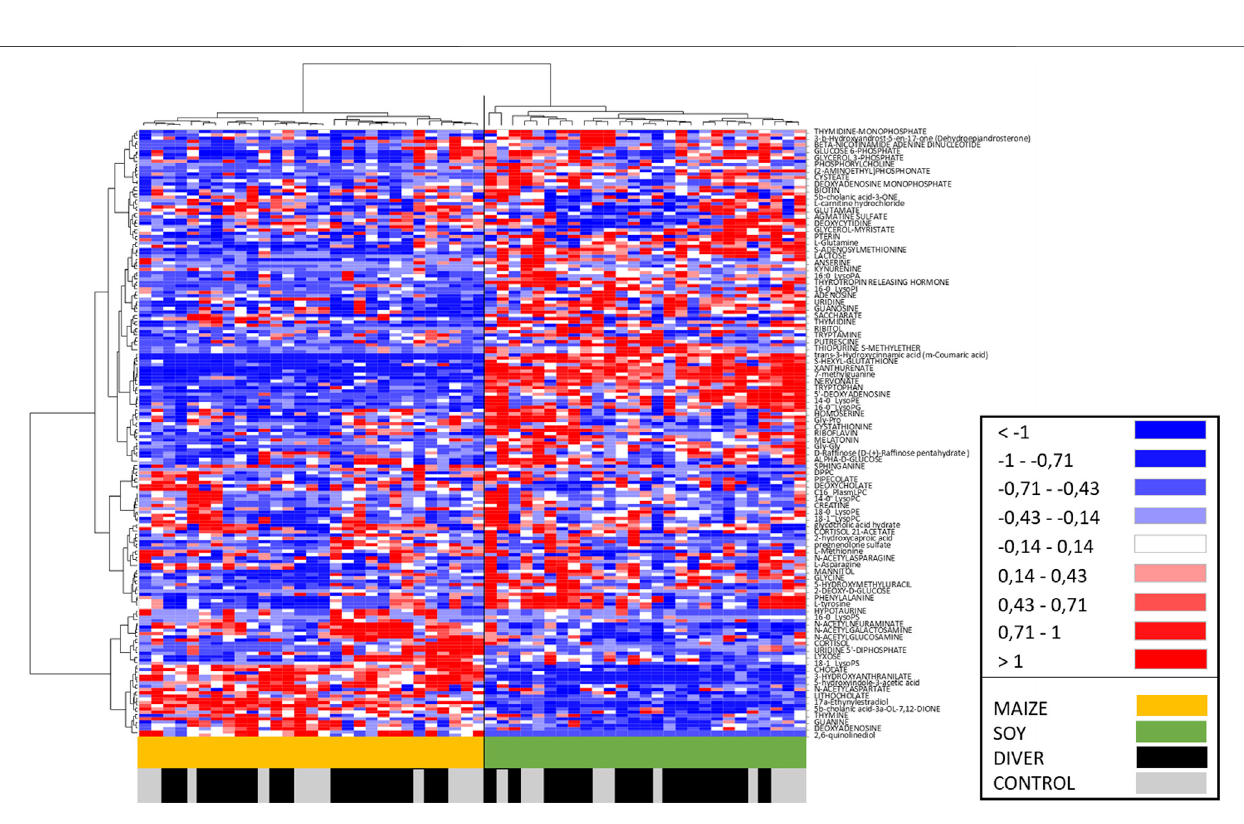
FIGURE6| HeatMap,i.e.,hierarchicalclusteringoffecalmetabolomesfromCtrl(grey)orDiver(black)rats.Ratsareontheordinatewheregreennotesratsfedwith soy and orange those fed with maize. Fold-change for each metabolite (abscissa) is represented by a color. Intensity values are normalized, from red (Min: − 1) to blue (Max: